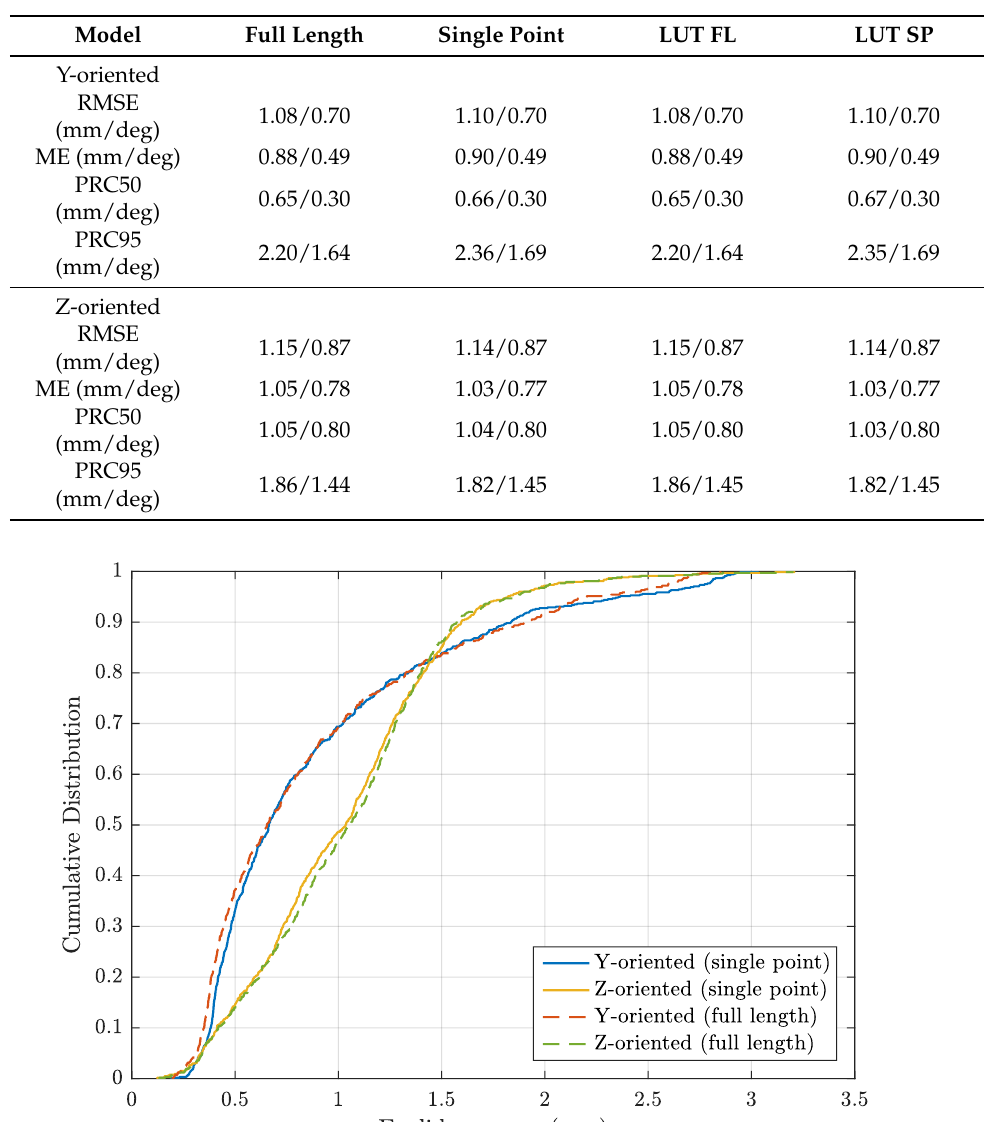
Table 2. Average positional and angular errors of a real electromagnetic tracking experiment, where the full-length and the single-point analytical and tabulated magnetic models are compared. Errors are calculated with respect to optical tracking ground-truth.